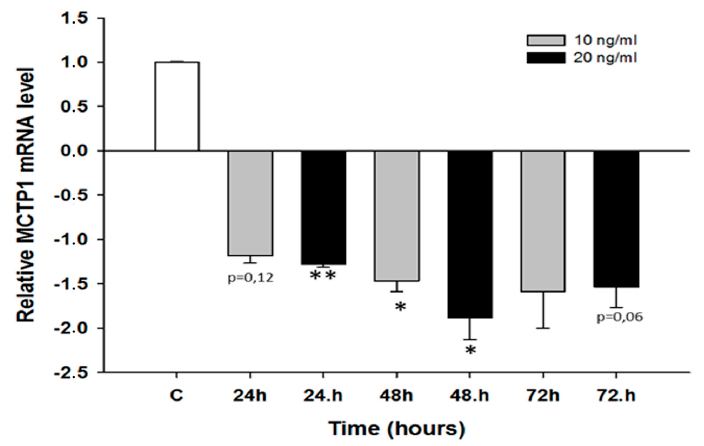
Figure 6. Expression analysis of the MCTP1 gene in W1 ovarian cancer cell line. The figure presents the relative gene expression in TOP-treated cells (grey and black bars) with respect to the untreated control (white bars), assigned as 1. The values were considered significant at * p < 0.05 and ** p < 0.01.